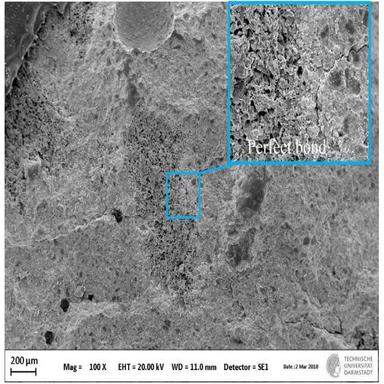
SEM analysis of the reference SB-REF mortar.